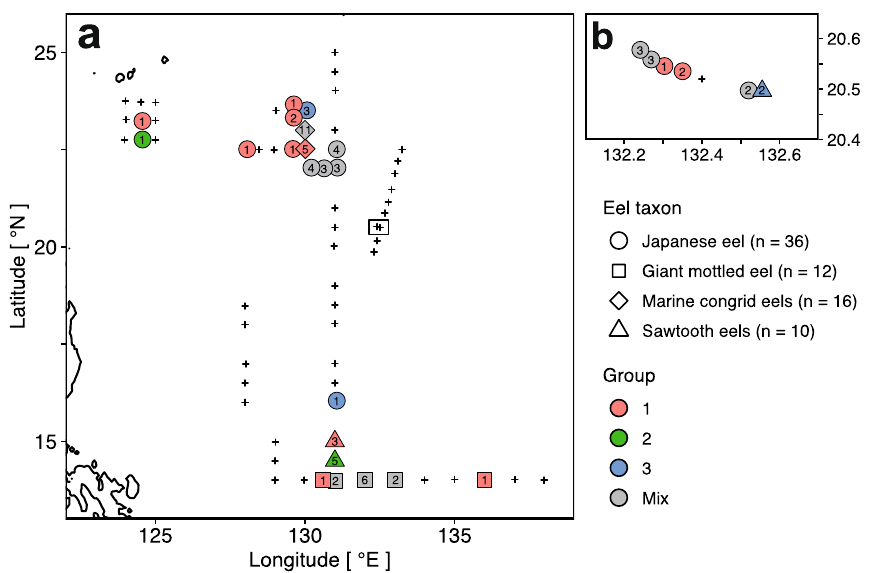
Figure 6. Distribution of four eel taxa within three cluster groups based on eukaryotic composition in gut content samples. Distribution of four eel taxa [circle ○ : Japanese eel, square □ : giant mottled eel ( Anguilla marmorata ), diamond ◇ : marine congrid eels ( Gnathopis spp.), and triangle △ : sawtooth eels ( Serrivomeridae spp.)]. Colors denote three cluster groups based on eukaryotic composition in the gut content samples in Fig. 5; gray indicates a mixture of multiple groups. Numbers on markers indicate the number of eel larvae. Note that a